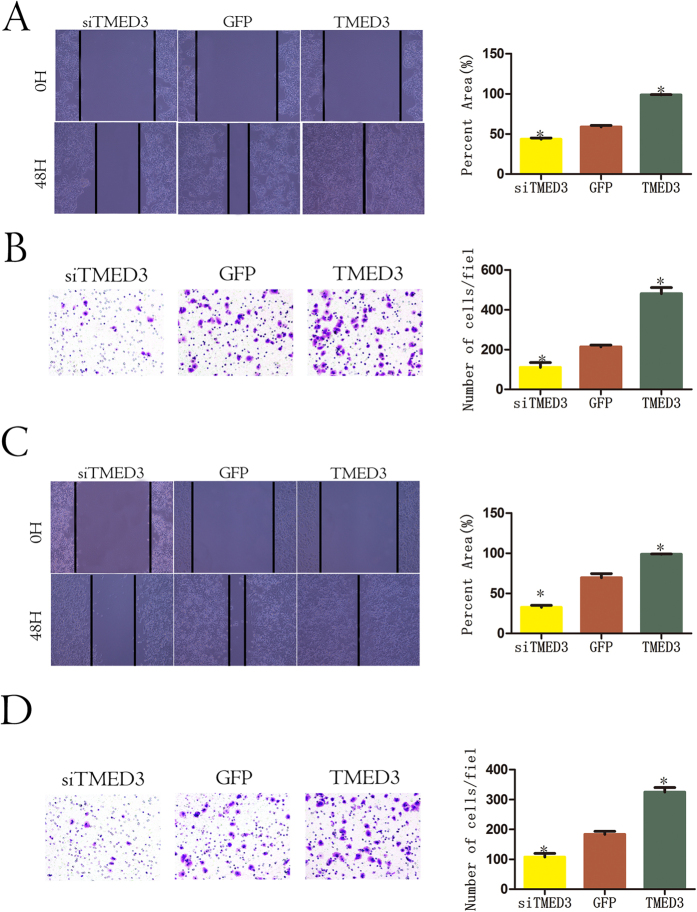
TMED3 promotes HCC metastasis in vitro.Wound healing and transwell migration assays showed that TMED3 knockdown inhibits migratory properties and that TMED3 overexpression promotes migration in the HCC-derived cell lines HepG2 (A,B) and Huh7 (C,D). Representative results and a statistical analysis are shown. (A–D) n = 3, mean ± SD. The Student’s t test, *p < 0.05 versus GFP control.